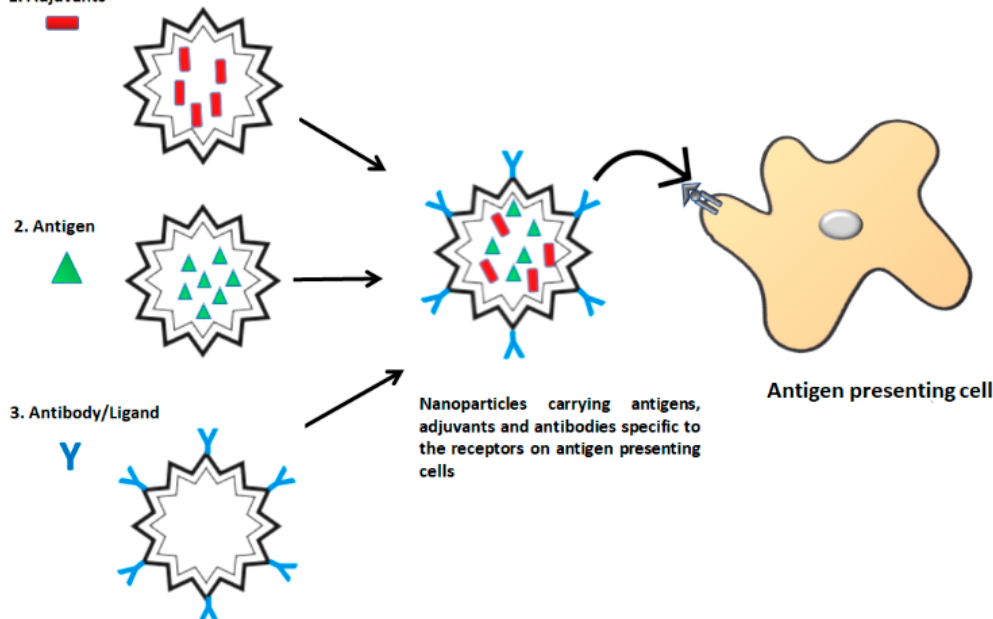
Figure 3. Illustration of nanoparticle-based antigen targeting. Various nanoparticles such as poly- D , L -lactide-co-glycolide (PLGA), polylactic acid (PLA), chitosan, liposomes and virus-like particles (VLPs) have been used for antigen targeting. These nanoparticles can be decorated on their surface with antibodies or ligands that can bind specifically to the antigen presenting cell receptors.